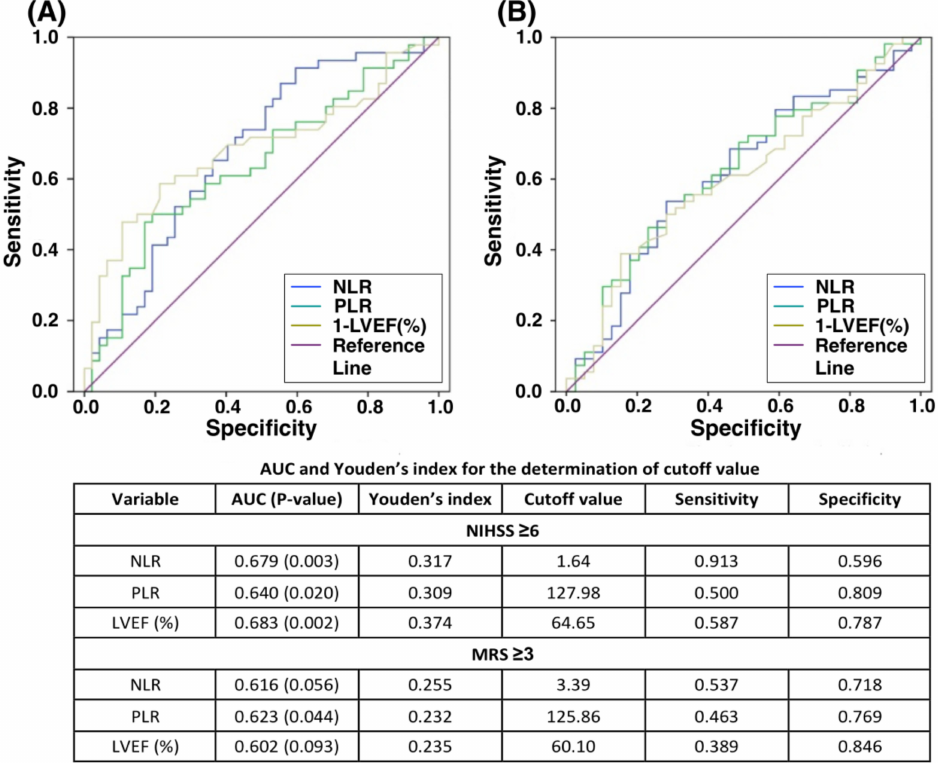
Figure 1. ROC curve for the correlation of NLR, PLR and LVEF to NIHSS (A) or MRS (B). ( A ) ROC curve reveals NLR, PLR and LVEF had mild correlation to NIHSS ≥ 6, with significantly acceptable discrimination power of AUC (0.640–0.683) for all three parameters. ( B ) Correlation of NLR, PLR and LVEF with MRS ≥ 3 were mild and only PLR exhibited significantly mild discrimination power of AUC (0.623, p = 0.004). Abbreviation: AUC, area under the receiver operating characteristic (ROC) curve; NIHSS, National Institute of Health Stroke Scale; MRS, Modified Rankin Scale; NLR, neutrophil-to-lymphocyte ratio; PLR, platelet-to-lymphocyte ratio; LVEF, left ventricular ejection